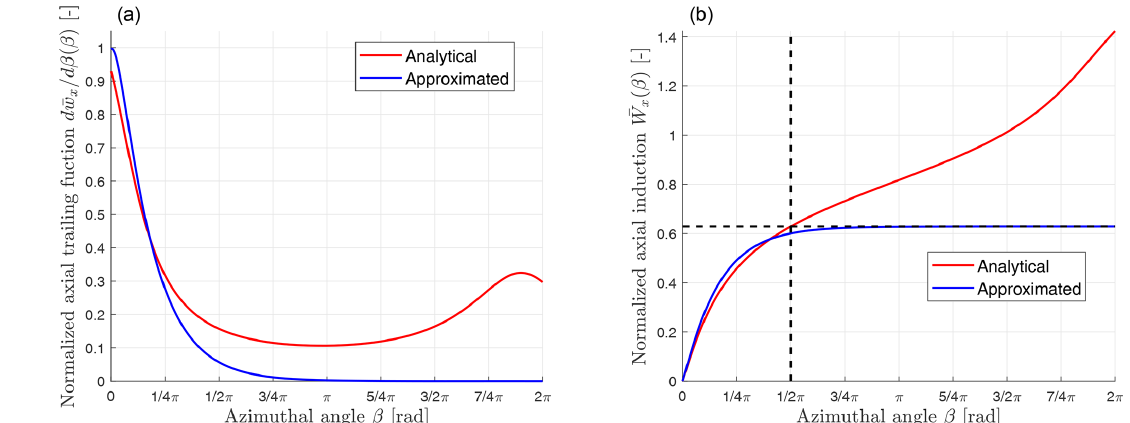
Figure 3. Illustration of the difference between the analytical and the approximated normalized trailing functions (a) and the corresponding induction functions (b) . The parameters for the illustration are h/r = 0 . 5, ψ = 10 ◦ and ϕ = 5 ◦ . The approximated steady-state near-wake induction is when β = ∞ and corresponds to the analytical near-wake induction at β = π 2